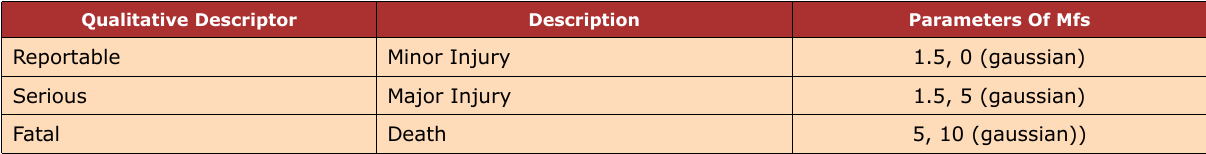
Table 3. Consequence of Severity (CS)